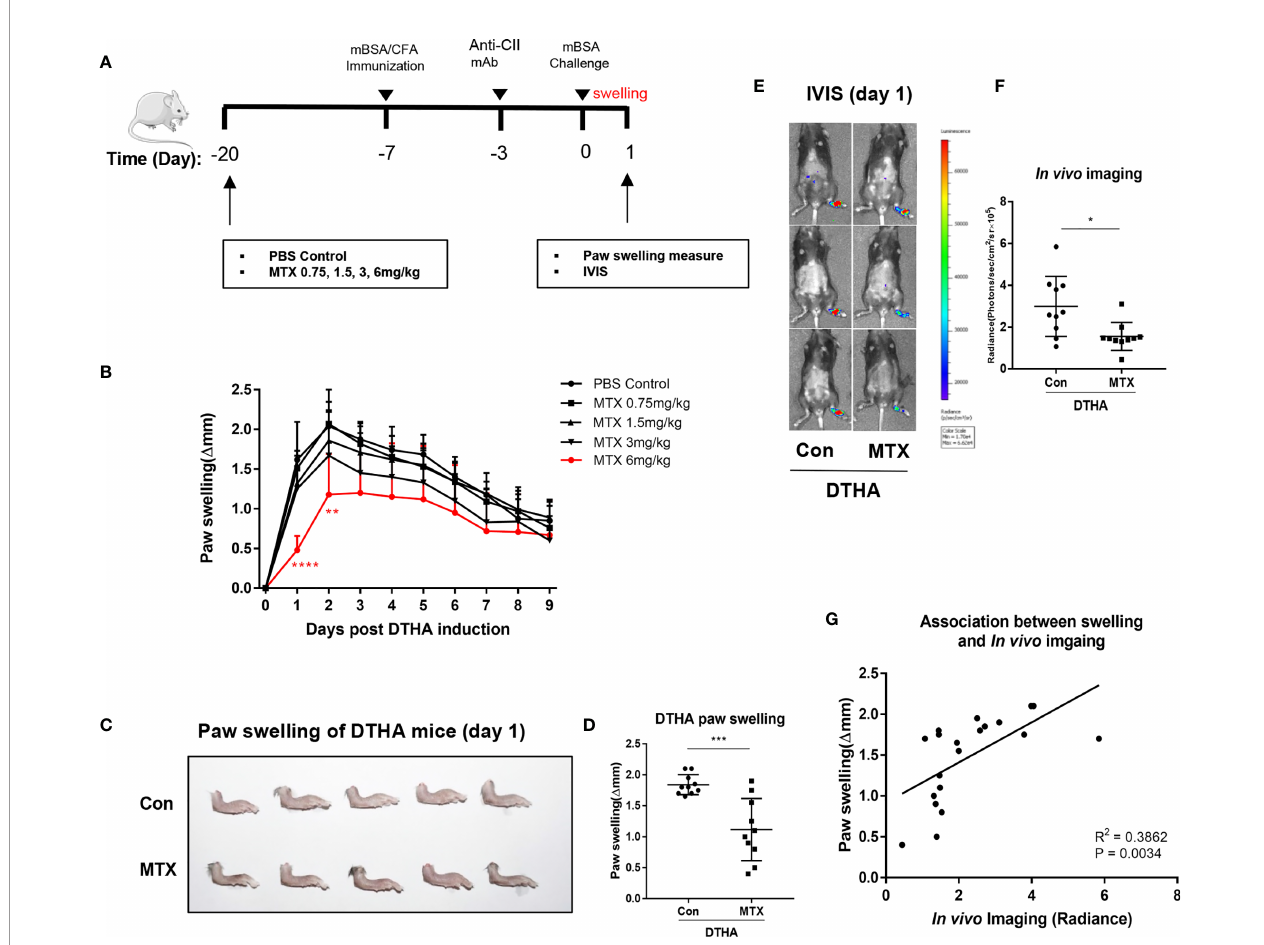
FIGURE 6 | MTX prevents DTHA-associated paw swelling and in fl ammation. (A) MTX treatment regime during DTHA induction is illustrated. (B) Effect of different dose of MTX (0 – 6 mg/kg) on paw swelling were monitored from day 0 to day 9 post DTHA onset. (C, D) Representative appearance (C) and quanti fi cation (D) of paw swelling in DTHA mice treated with and without MTX (6 mg/kg). (E) Representative bioluminescent images indicting myeloperoxidase (MPO) activity of hind paws from DTHA mice treated with and without 6 mg MTX/kg on day 1. (F) Quanti fi cation of in vivo luminescence imaging for mice treated with and without MTX (6 mg/kg). (G) Linear regression analysis of paw swelling and in vivo luminescence imaging for MPO activity in DTHA mice treated with and without MTX (6 mg/kg). The data are representative of pooled data from two independent experiments with fi ve mice in each group per experiment, with the exception of the data of 0.75 and 3 mg/kg MTX treatment, which are from one experiment with fi ve mice. Statistical signi fi cance was calculated by Student ’ s t-test for the comparison of two mouse groups (*p < 0.05, **p < 0.01, ***p < 0.001, ****p < 0.0001). Stars under the curve in panel B represent signi fi cant difference in paw swelling between 6 mg MTX/kg treatment group and PBS-treated control group (**p < 0.01, ****p < 0.0001). The correlation between paw swelling and imaging was calculated by Pearson correlation test. Con, DTHA Control group. The mouse image is from